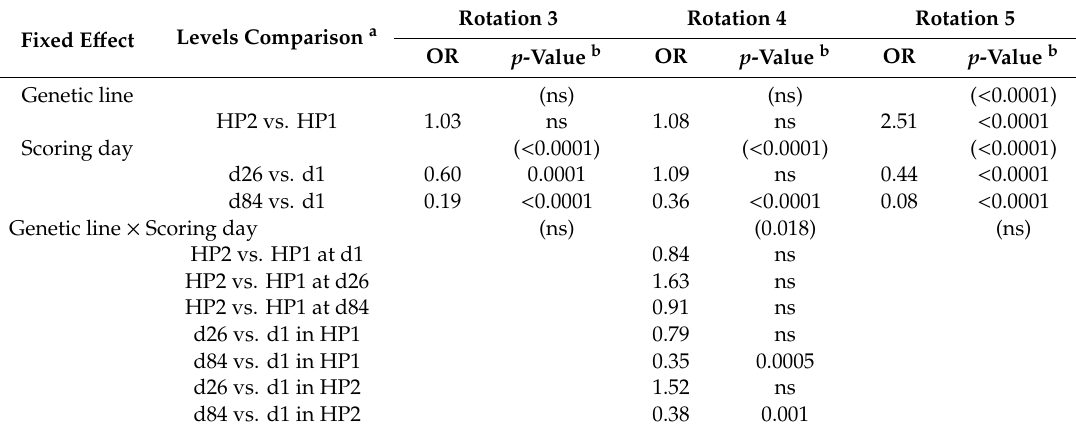
Table 5. Summary of the impact of genetic line (HP2 vs. HP1), scoring day (d1, d26, and d84) and their interaction on TOTAL body lesion scores within each rotation (3, 4, and